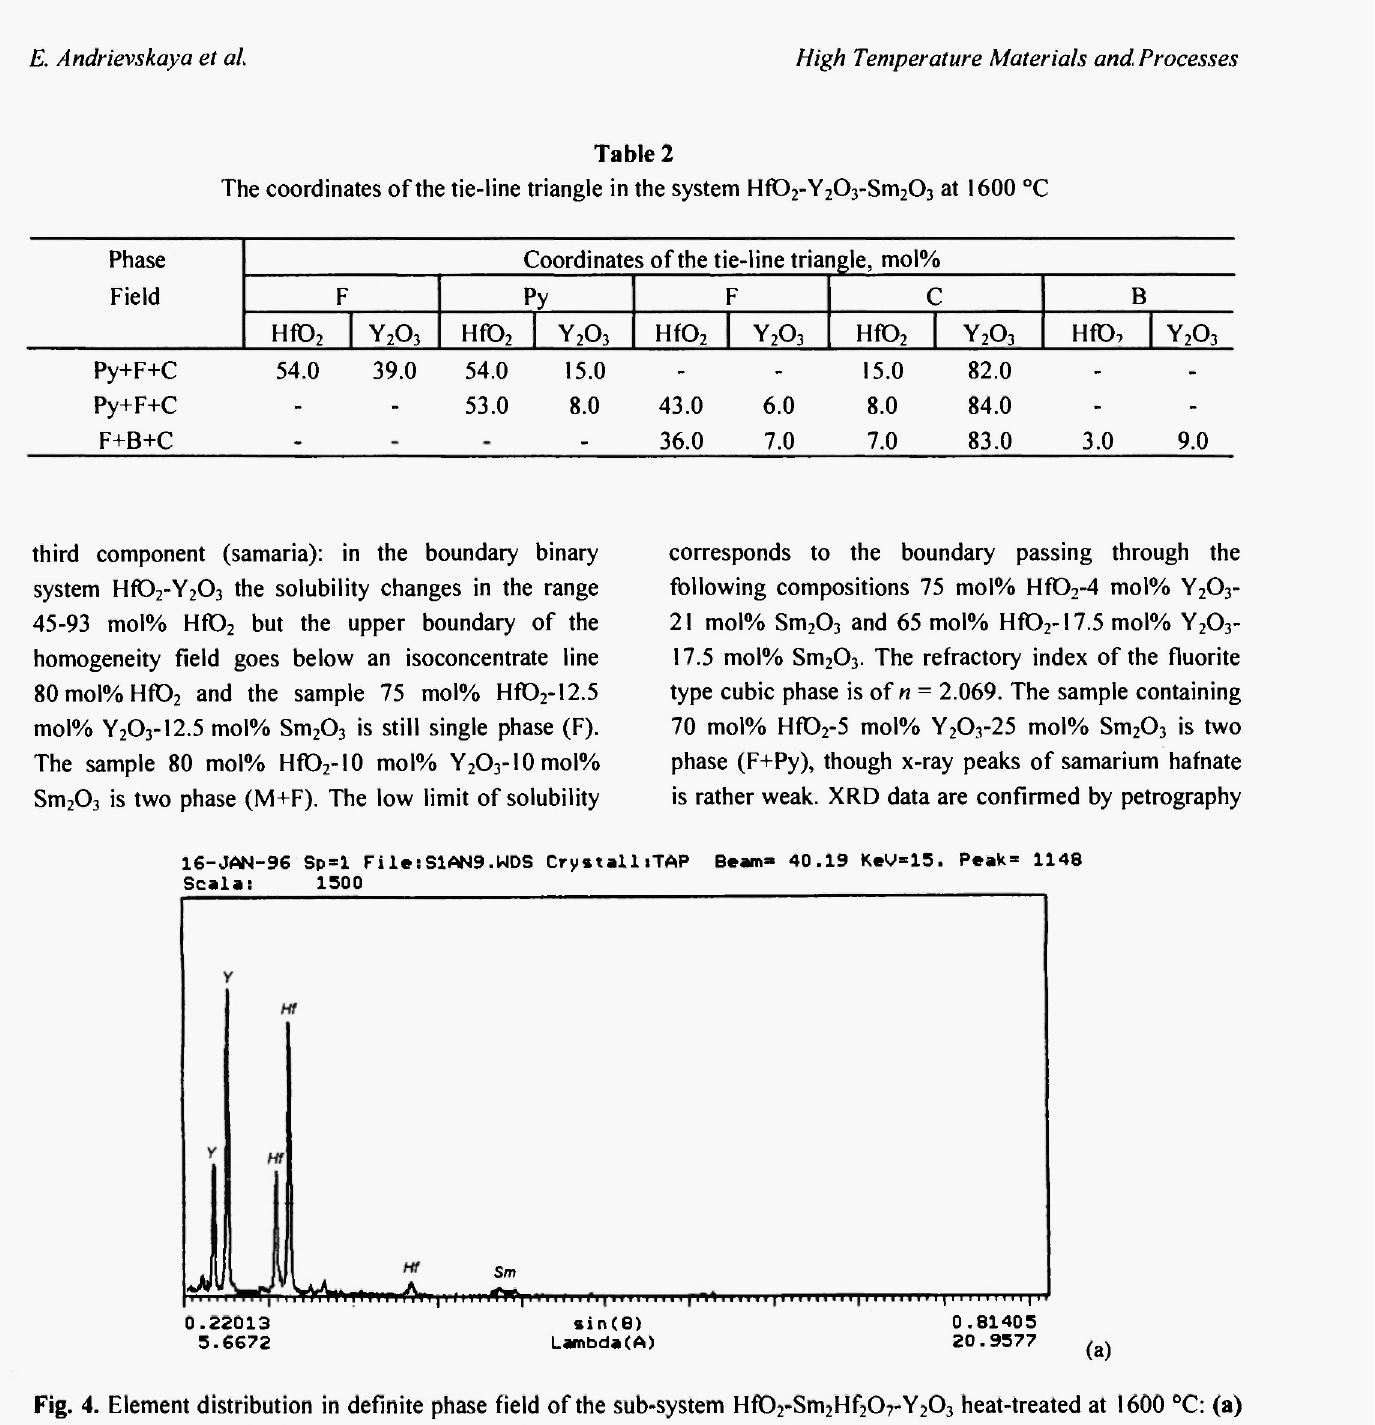
Fig. 4. Element distribution in definite phase field of the sub-system HfD 2 -Sm 2 Hf 2 07-Y 2 0 3 heat-treated at 1600 °C: